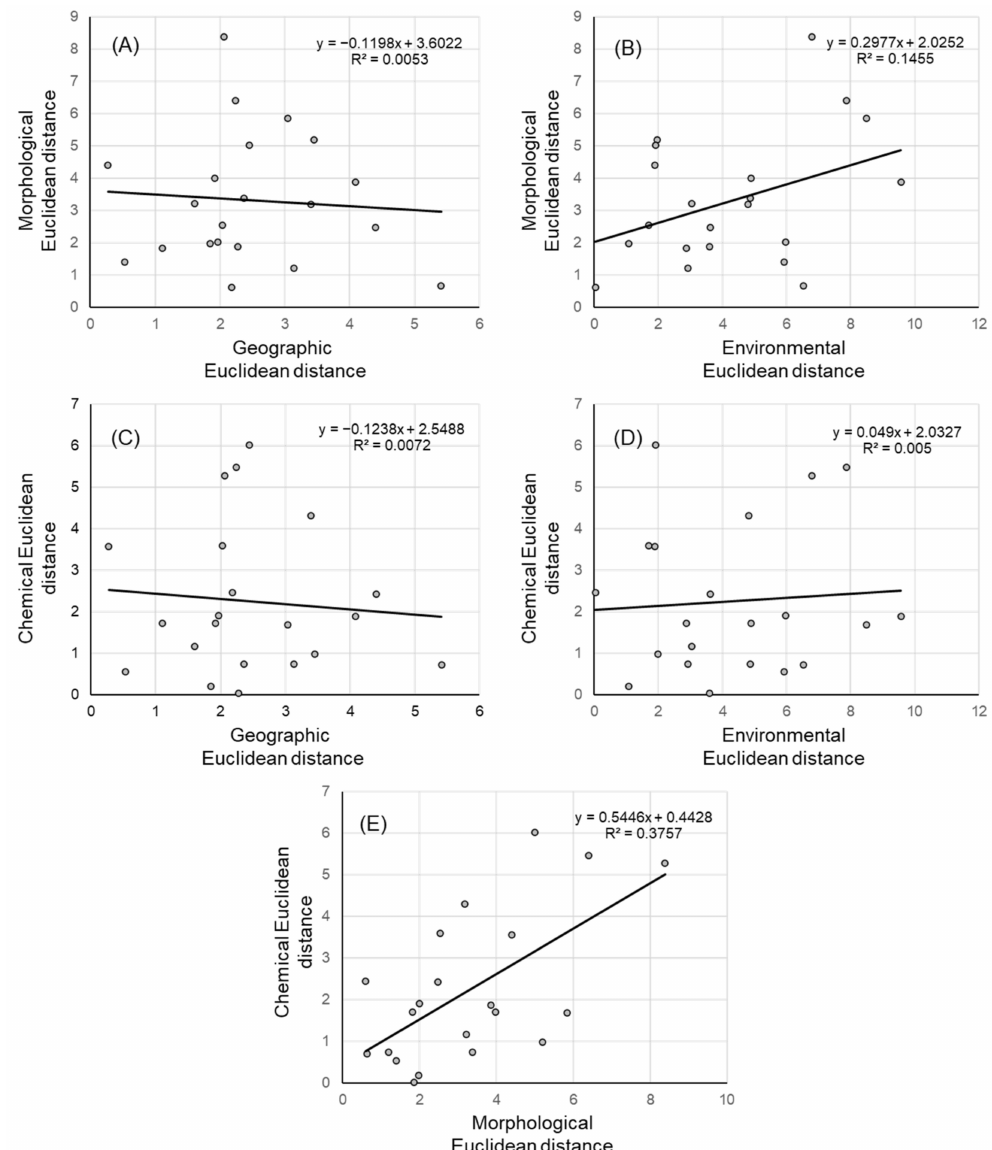
Figure 6. Isolation-by-distance and Isolation-by-environmental distance. Scatter plots of simple Mantel tests showing the relationships between ( A ) geographic and morphological distances (r = –0.0729, p = 0.58), ( B ) environmental and morphological distances (r = 0.3814, p = 0.05), ( C ) geographic and chemical distances (r = –0.0848, p = 0.47), ( D ) environmental and chemical distances (r = 0.0706, p = 0.37), and ( E ) morphological and chemical distances (r = 0.6129, p =